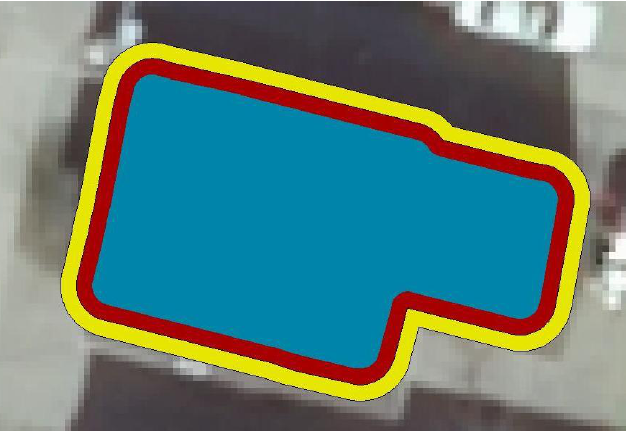
Figure 4. Ring extent: the inner roof area, the outer roof edge, the outer roof buffer and the remaining of the area surrounding a particular building are represented in blue, red, yellow and colorless